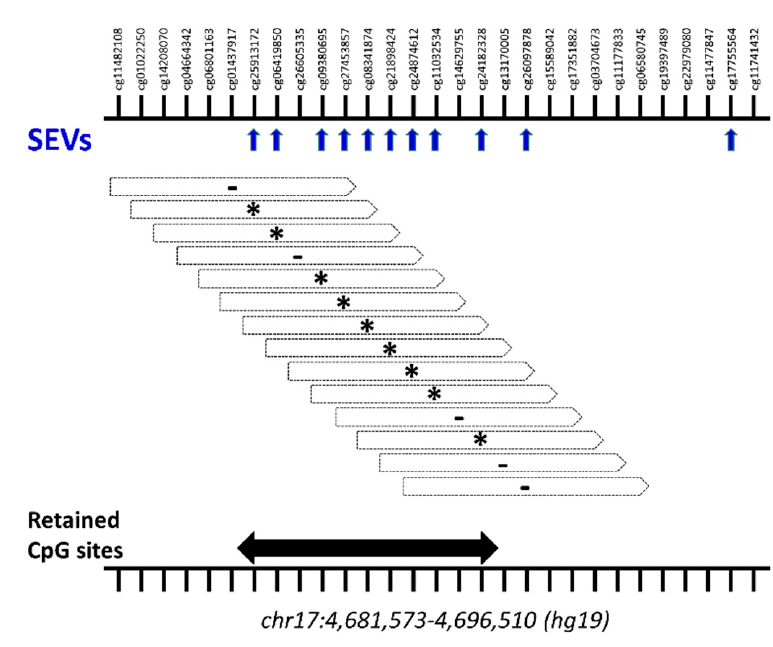
Figure A2. Schematic representation of the functioning of the sliding window approach on an exemplificative OAVS sample by considering an 11 sites window. Arrows show the genomic position of SEVs. Asterisks indicate significant SEV-enriched-windows while, on the contrary, the dashes point to those not meeting the required criteria. The genomic representation of CpG sites is not in scale.